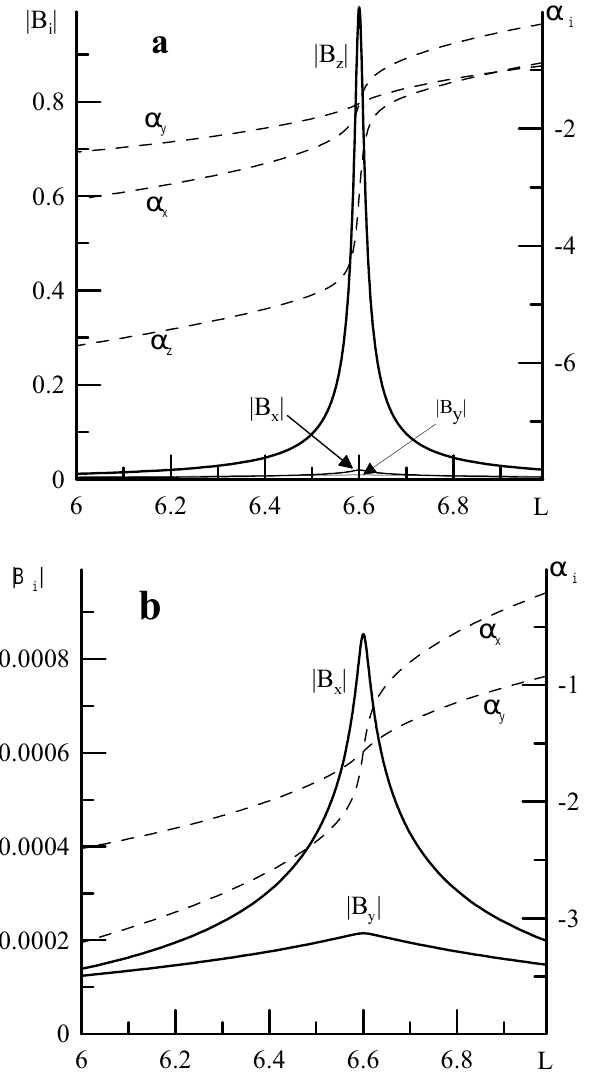
Fig. 5. Transverse structure of magnetic field components ( i = x,y,z ) of the first harmonic ( N = 1) of the SMS oscillations in the resonant region near L = 6 . 6: (a) the amplitude | B i | and phase α i distributions close to the equatorial plane, and (b) above the iono- sphere. At the ionospheric boundary the compressional component B z